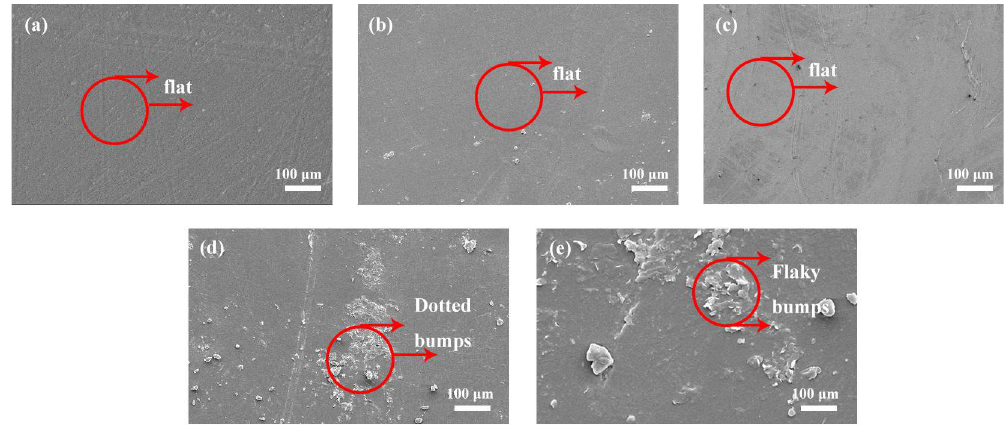
Figure 6. SEM surface images: ( a ) EP, ( b ) 3-FEP, ( c ) 5-FEP, ( d ) 7-FEP, ( e ) 10-FEP.